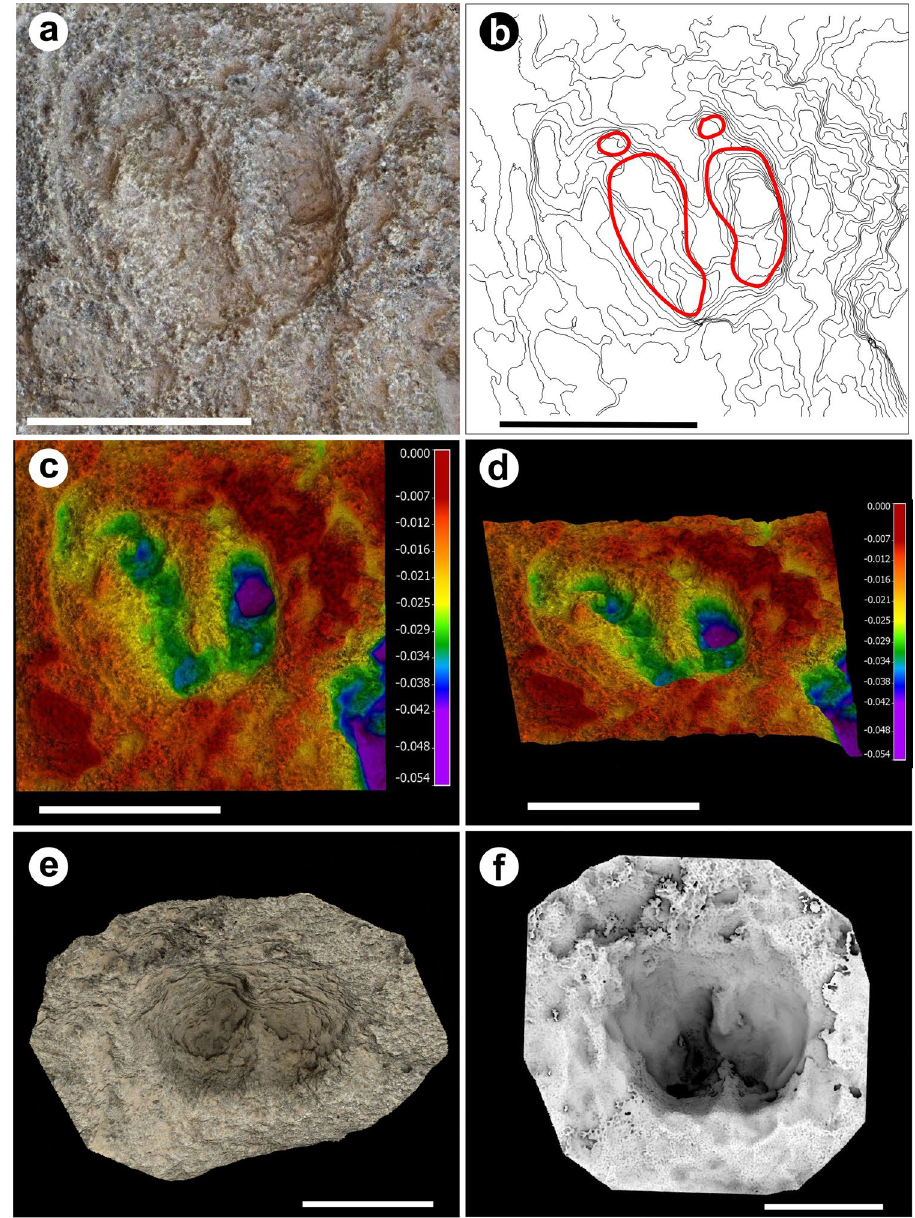
Figure 4. 3D models of the Bovinichnus uripeda holotype (TTS10) and paratype TTS8: ( a ) Orthogonal view of the natural colours textured 3D model of the TTS10 with the general morphology depicted from the contour lines map, equidistance of 1 mm ( b ); ( c ) false colour DSM in orthogonal view showing deeper areas in the heel side of the hooves and the tips resulting from the impulse created in the foot-off event. The circular-to-elliptical dew claw imprints are also evident behind the hooves; ( d ) oblique view of the previous DSM to complement previous observations; ( e ) oblique view of the textured natural colour 3D model of the paratype TTS 8; ( f ) orthogonal view of the paratype TTS 8 where the deepest part of the hoofprints is displaced to their anterior part reflecting the pressure angle exerted by the limb on the substrate during the foot-off event. Scale bar is 150 mm. The 3D model of the images ( a–d ) were produced by the software WebODM 2.1.0, https:// github. com/ OpenD roneM ap/ WebODM; MeshLab 2020.12, (https:// www. meshl ab. net/); CloudCompare 2.11.0, (https:// www. danie lgm. net/ cc/) and the 3D model of the images ( e,f ) were produced with the software Meshroom 2021.1.0, (https:// alice vision. org/# meshr oom); MeshLab 2020.12, (https:// www. meshl ab. net/); CloudCompare 2.11.0, (https:// www. danie lgm. net/